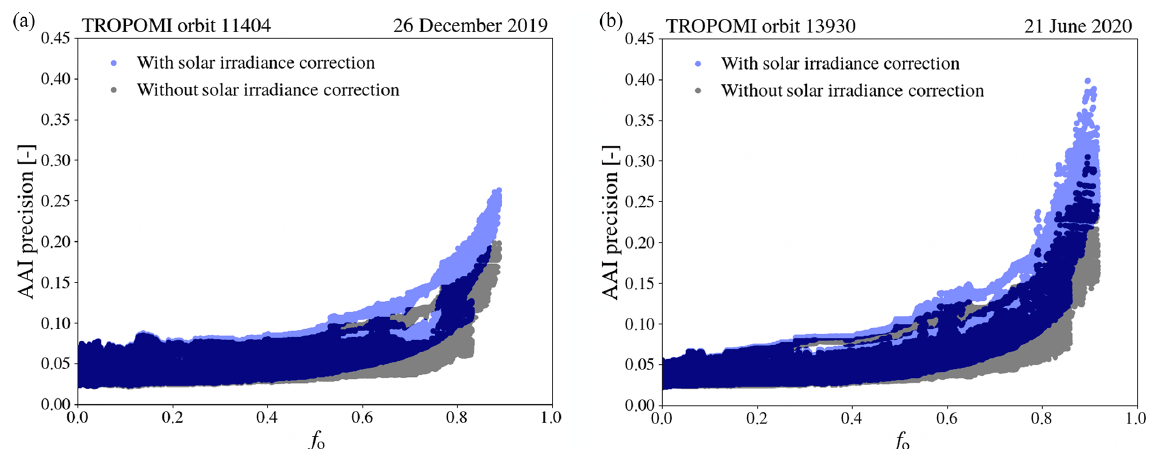
Figure B1. Precision of the AAI in the eclipsed TROPOMI orbits on 26 December 2019 (a) and 21 June 2020 (b) as a function of obscuration fraction f o at 380nm, with solar irradiance correction such that both σ R meas and σ (cid:48) are propagated (semi-transparent blue dots) and without solar irradiance correction such that only σ R meas is propagated (semi-transparent black dots).